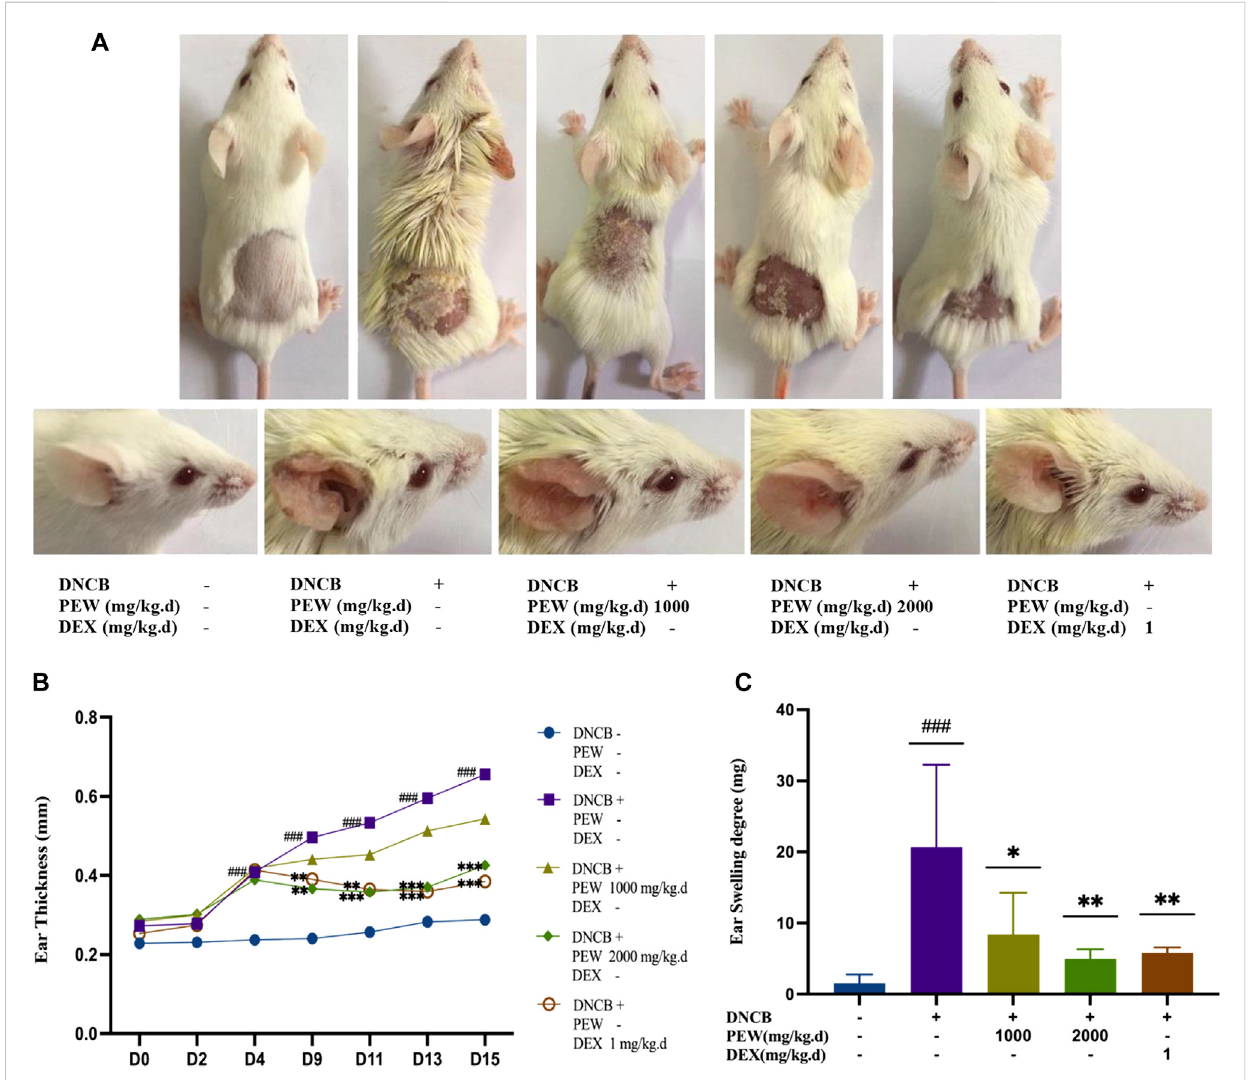
FIGURE 2 PEW ameliorates DNCB-Induced AD-like symptoms in Balb/c mice. (A) . Representative images of dorsal skins and ears in each group (day 15). (B) Changes in ear thickness weremeasured and recorded ( n = 9 – 10/group). (C) The ear swelling degree was recordedas the right ear weight minus theleft earweight(a7 mmpunch)attheendpoint( n =7 – 10/group).Thedatawerepresentedasmeans±SD.### p < 0.001,VS.thenormalgroup;* p < 0.05,** p < 0.01, *** p < 0.001, VS. the model control